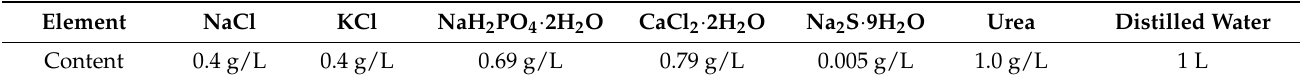
Table 3. Composition of artificial saliva according to the Fusayamya–Meyer formula